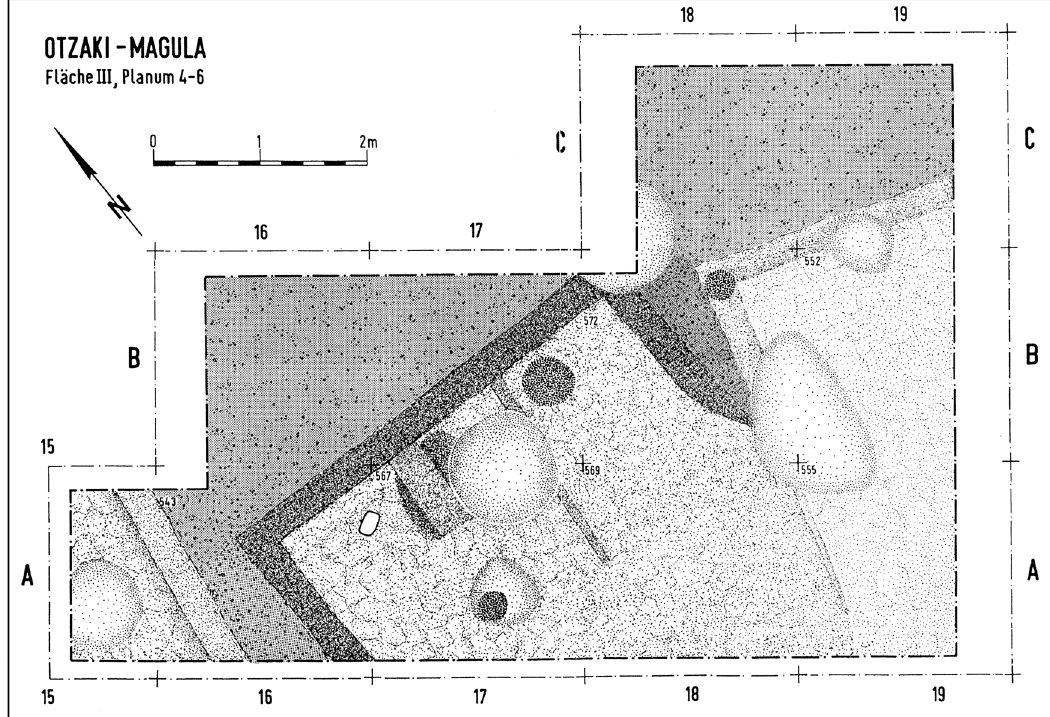
Figure 6: Architectural remains of the late Early Neolithic at Otzaki ( Miloj č i ć , 1971, Plan VIII )